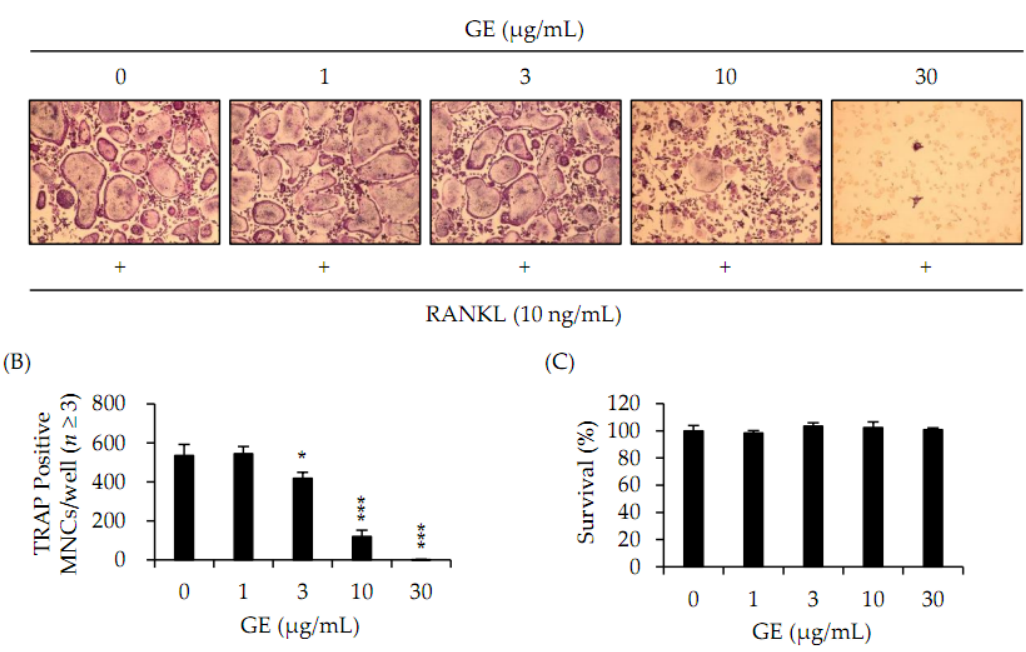
Figure 1. Gracilaria verrucosa extracts suppresses osteoclastogenesis. ( A ) Bone marrow macrophages (BMMs) were cultured for 4 days with receptor activator of NF- κ B ligand (RANKL) (10 ng/mL) and macrophage colony-stimulating factor (M-CSF) (30 ng/mL) in the presence of the indicated concentrations of GE or vehicle (0.1% distilled water (DW)). Cells were fixed in 3.7% formalin, permeabilized in 0.1% Triton X-100, and stained for TRAP; ( B ) TRAP + -multinucleated cells ( n ≥ 3) were counted as osteoclasts. * p < 0.05, *** p < 0.001; ( C ) Effect of GE on the viability of BMMs was evaluated by performing CCK-8